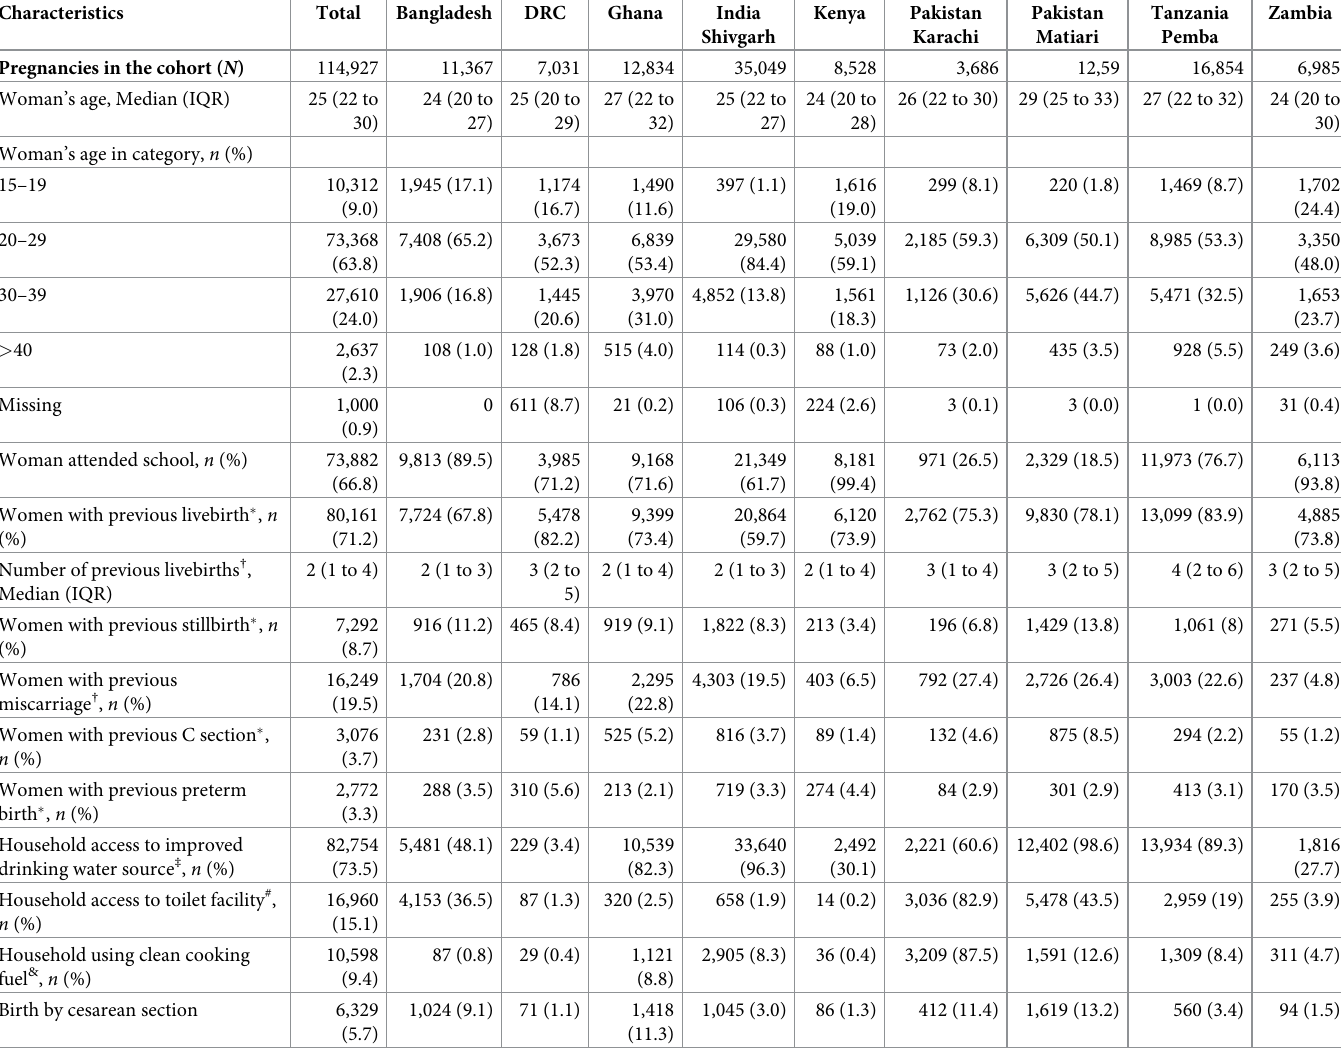
Table 1. Baseline characteristics of pregnant women enrolled in AMANHI maternal morbidity study.